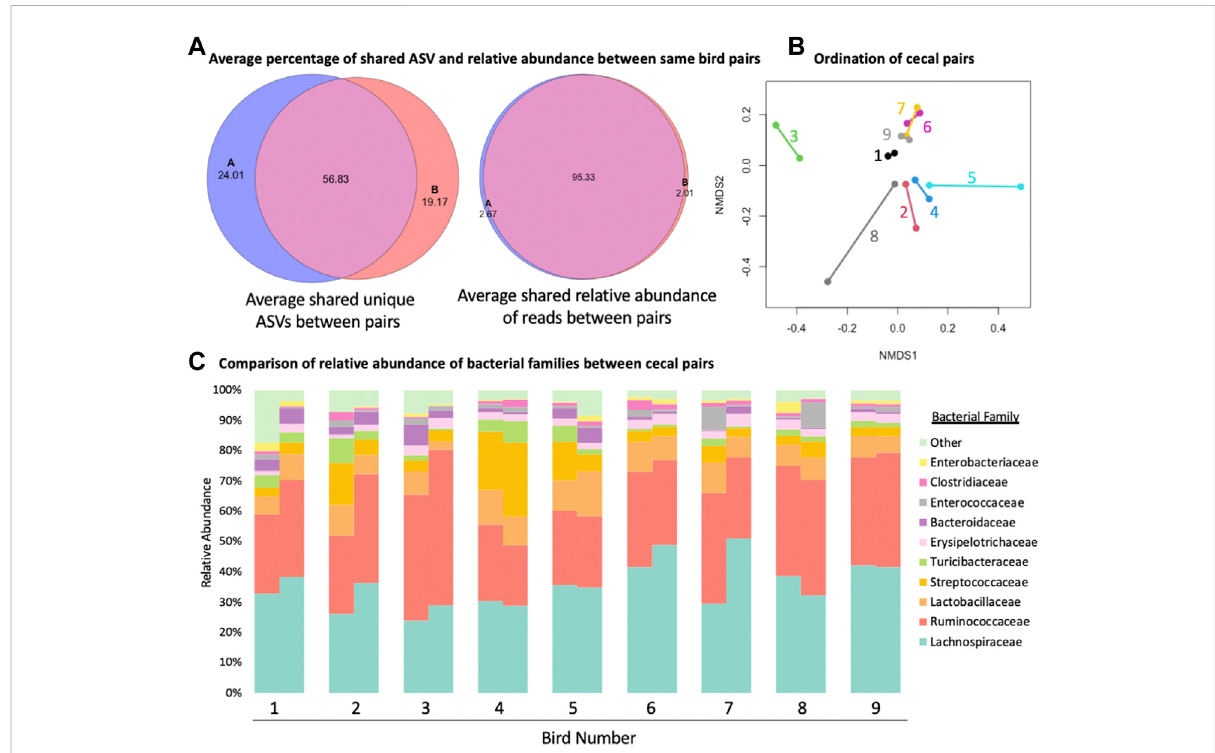
Comparison of similarity of the two cecal pouches within the same bird. (A) The average number of shared amplicon sequence variants (ASVs) betweenthetwocecalpouchesofthesamebirdandtheaveragesharedrelativeabundancebetweenofreadsbetweenthetwocecalpouchesofthe same bird. (B) Bet diversity of ordination of cecal pairs colored and connected by pair mate. (C) Staked taxonomic bar plot of relative abundance of bacterial families between cecal pairs from the same